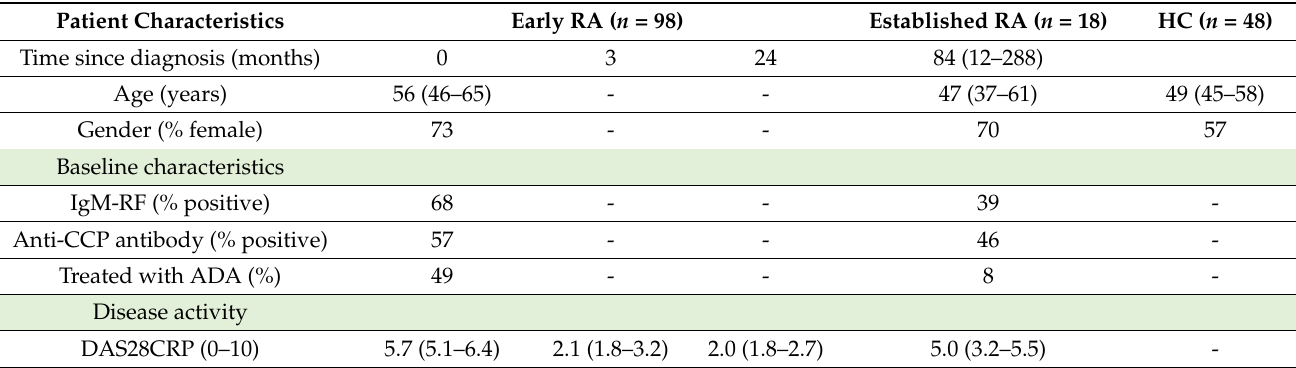
Table 1. Patient characteristics in treatment-naïve early rheumatoid arthritis (RA) ( n = 98), established RA ( n = 18), and healthy controls (HC) ( n = 48). Data are expressed as median with IQR range unless otherwise indicated. ADA Adalimumab, CCP Cyclic citrullinated peptide, DAS28CRP